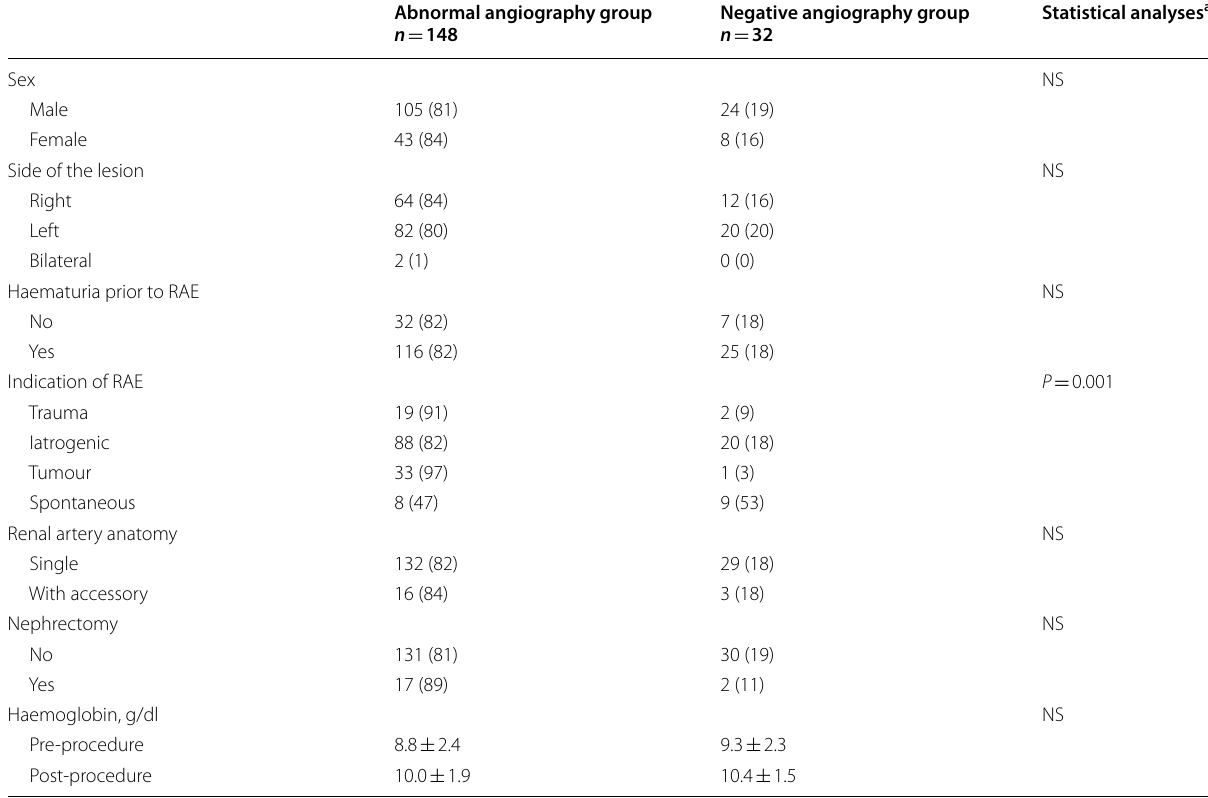
Data presented as mean SD or n of patients (%) ± Percentages given for rows and decimals deleted for simplification a χ 2 -test was used for categorical data and paired sample t test was used for normally distributed continuous data; NS not significant ( P